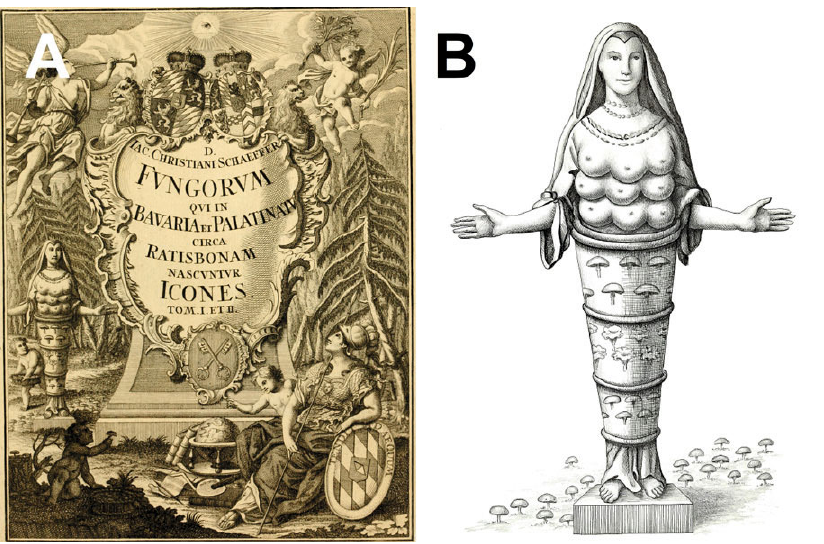
Fig. 1. A. Diana “Funga” as depicted on the cover of Schaeffer (1774). B. Reproduction by the Brazilian artist Claudio Toscan